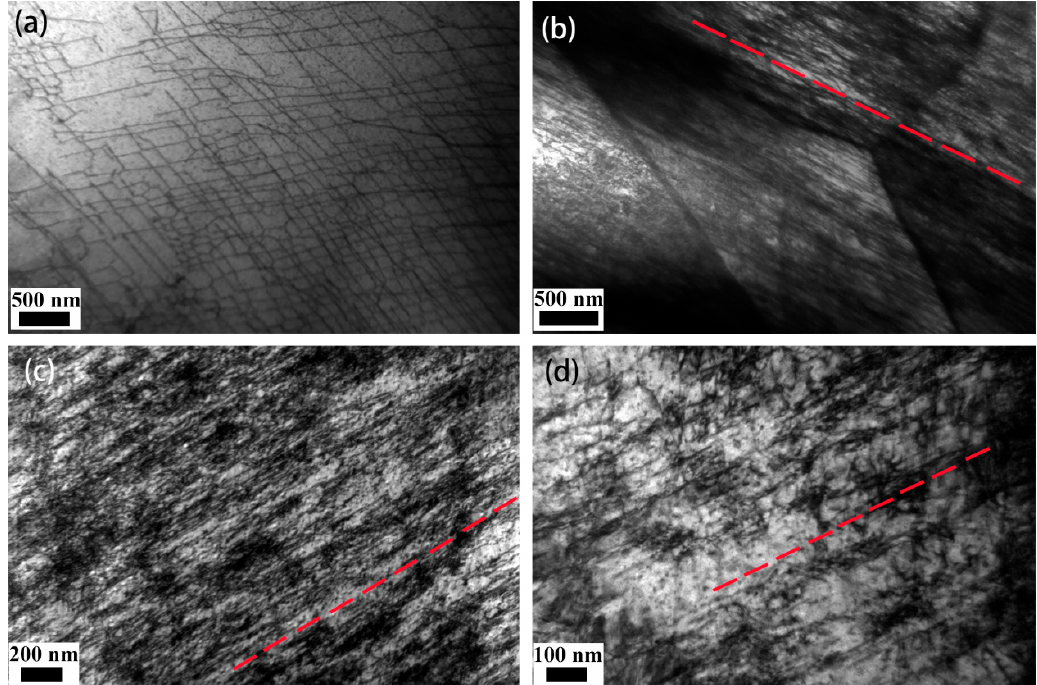
Figure 8. Dislocation configurations in the center samples. ( a ) Before the tensile tests; ( b ) the loaded center sample at the critical strain at 350 °C; ( c ) samples after tensile deformation at 350 °C in the location with high dislocation density; ( d ) samples after tensile deformation at 350 °C in the location with low dislocation density.